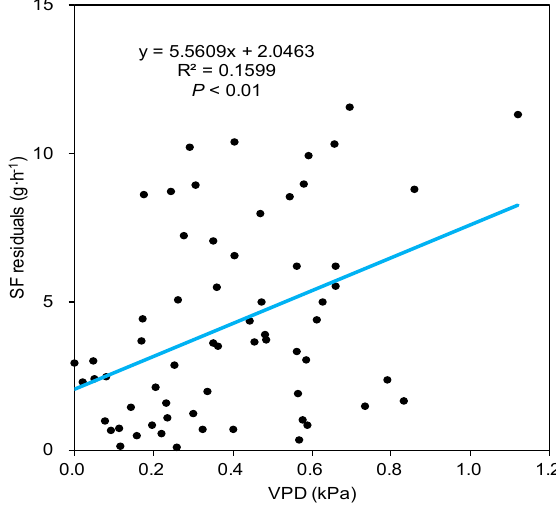
Figure A2. Regression relationships between the daily SF residuals and VPD.